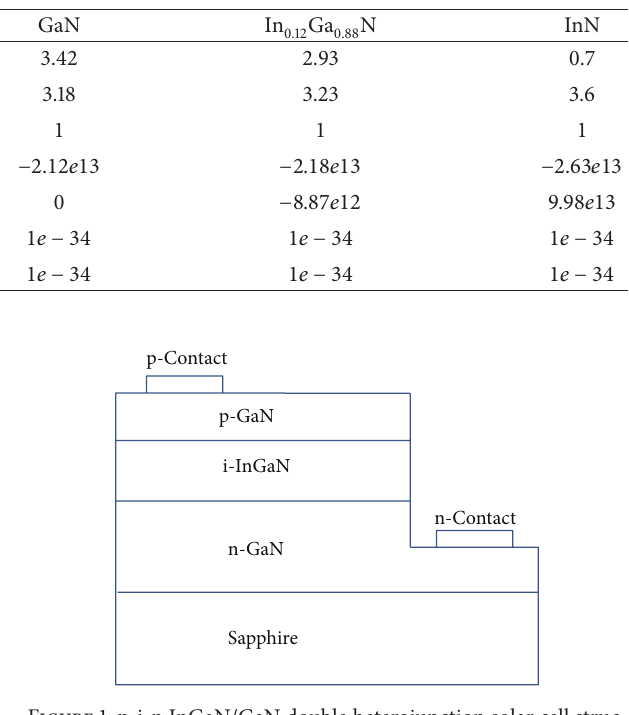
Figure 1: p-i-n InGaN/GaN double heterojunction solar cell struc-